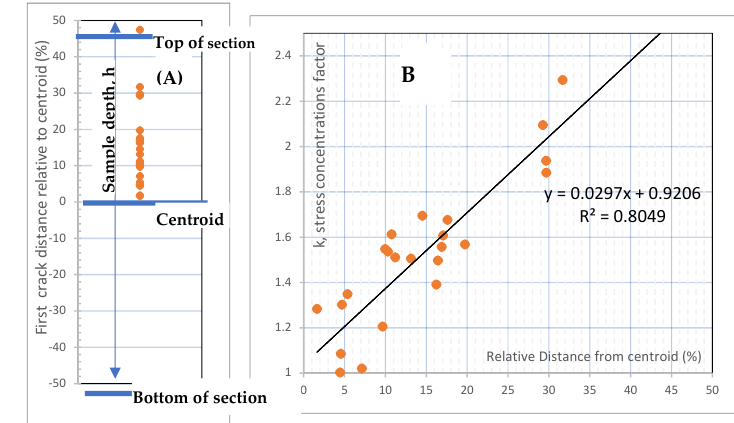
Figure 4. ( A ) Absolute distance of first cracks in specimens relative to section centroid. ( B ) Stress concentration as in Equation (1). Stress concentration was calculated based on Equation (1). As this diagram shows, stress concentration increased with distance from the centroid. This suggests that the size of imperfections and flaws increased with the distance from the centroid.